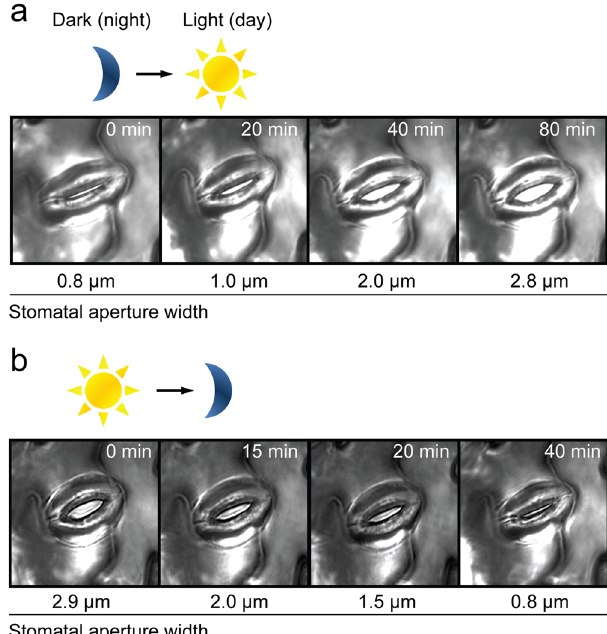
Fig. 1 Guard cells respond to light signals. a , b Time course of light- induced stomatal opening ( a ) and dark-induced stomatal closure ( b ) with actual stomatal aperture width indicated below; dark-to-light transition mimics night-to-day transition which opens stomatal pores ( a ) and light-to- dark transition mimics day-to-night transition which closes stomatal pores ( b ), light intensity 150 µ mol m − 2 s − 1